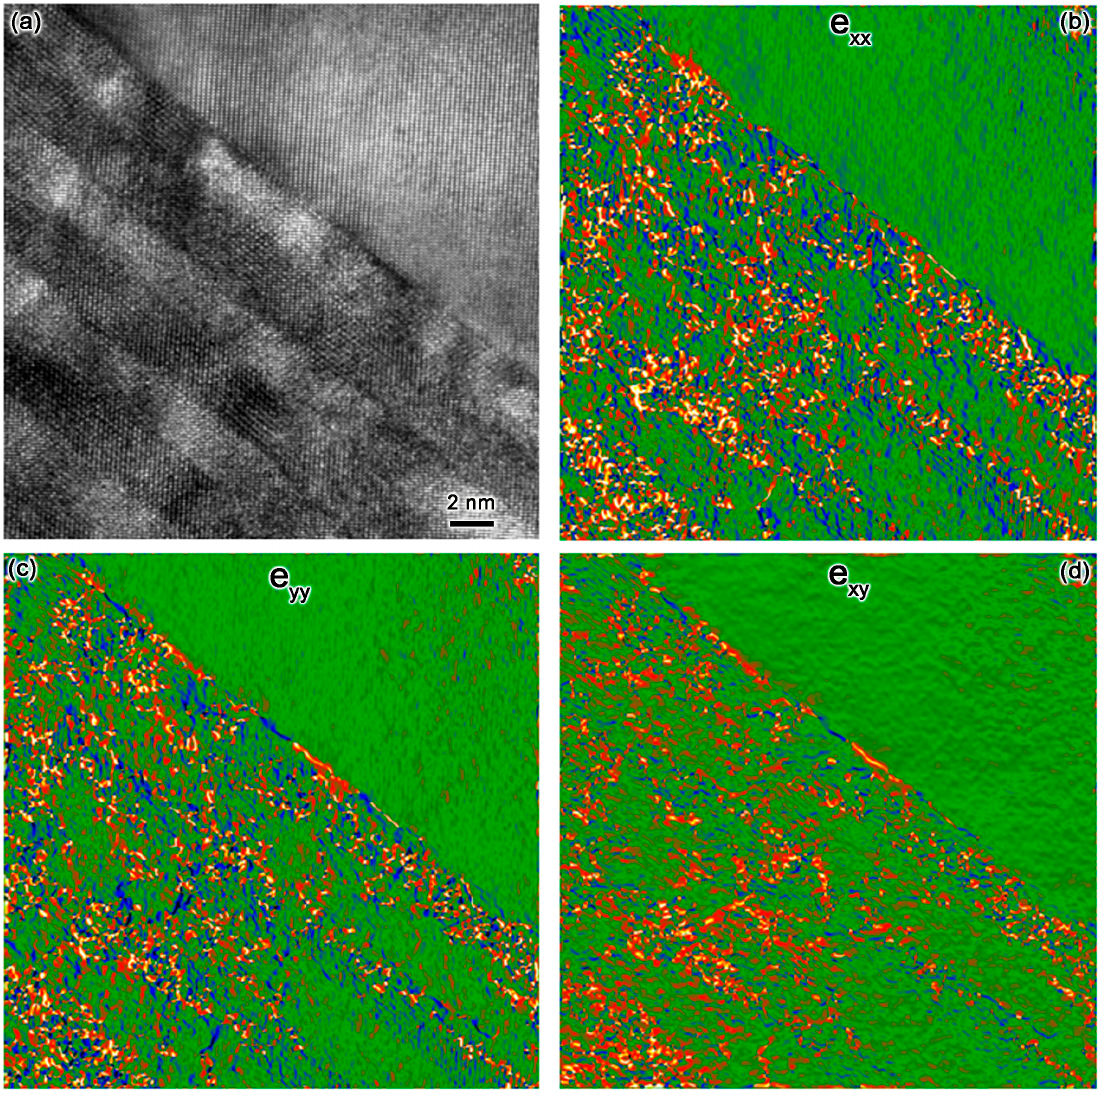
Figure 9. ( a ) A typical HRTEM image of sample-III; ( b – d ) are pure strain e xx and e yy , as well as torsional strain e xy (e xx and e yy are pure strain along the x and y axes, while e xy is a torsional strain) that are extracted from geometric phase analysis,